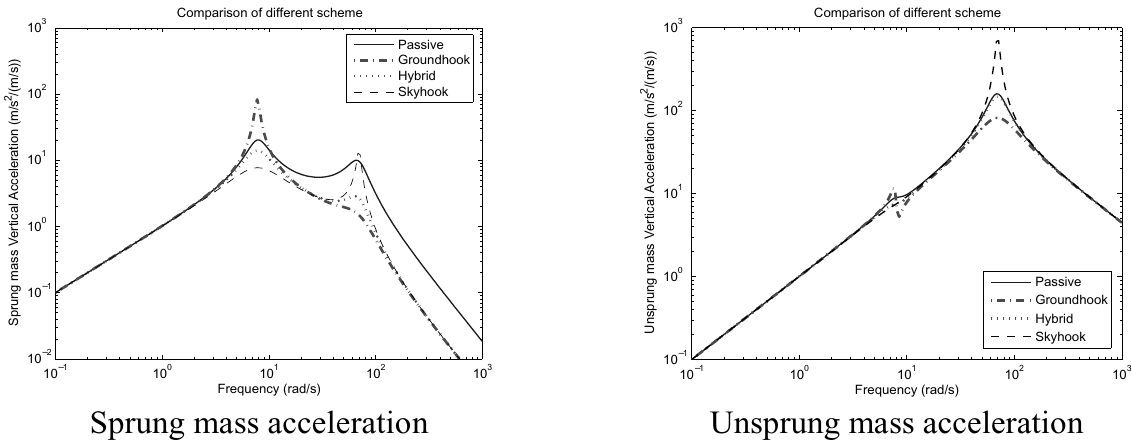
Fig. 10. Sprung mass and unsprung mass acceleration frequency response.